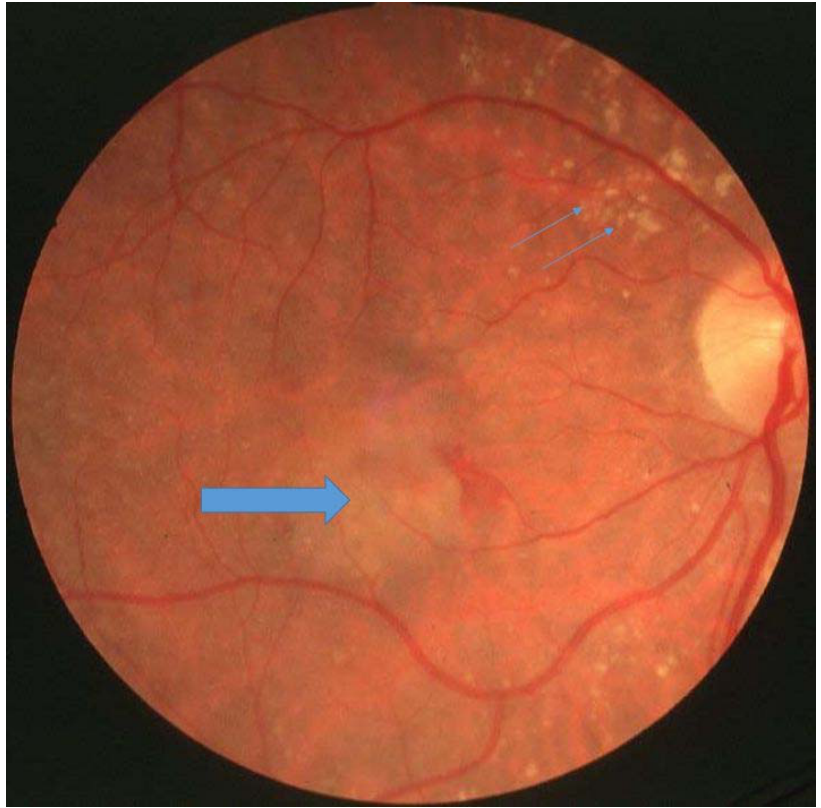
Figure 1. Patient with Sorsby’s fundus dystrophy with drusen (small arrows) and choroidal neovascularisation (large